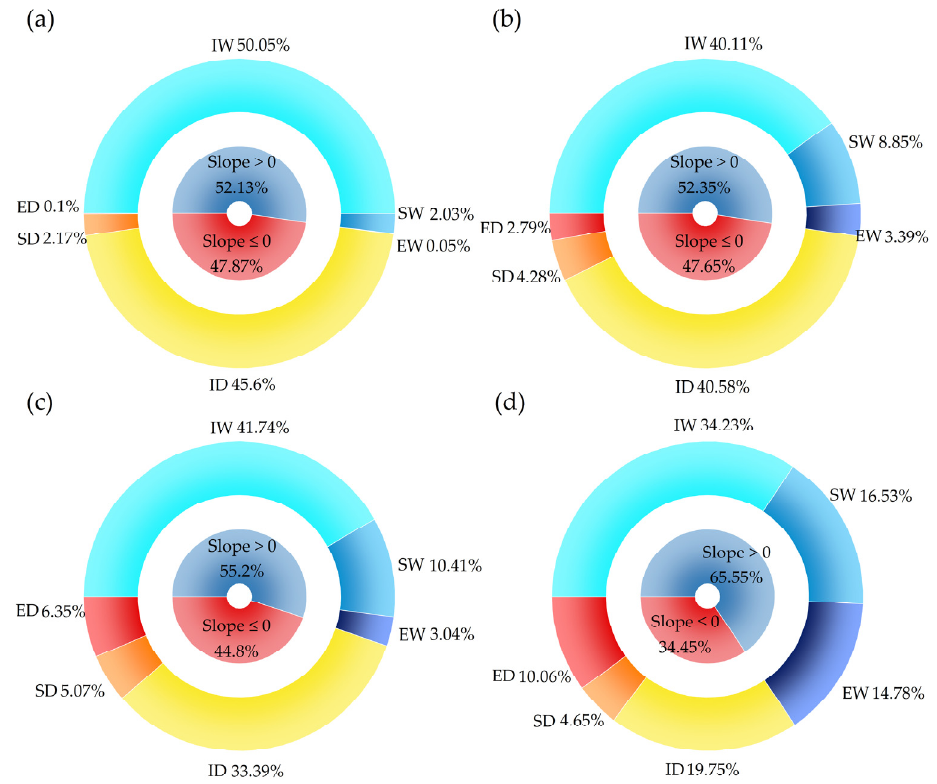
Figure 8. SPEI-12 changes on the TP from 2016 to 2099 under four climate scenarios: ( a ) RCP2.6, ( b ) RCP4.5, ( c ) RCP6.0, and ( d ) RCP8.5. IW-insignificant wetting, SW-significant wetting,